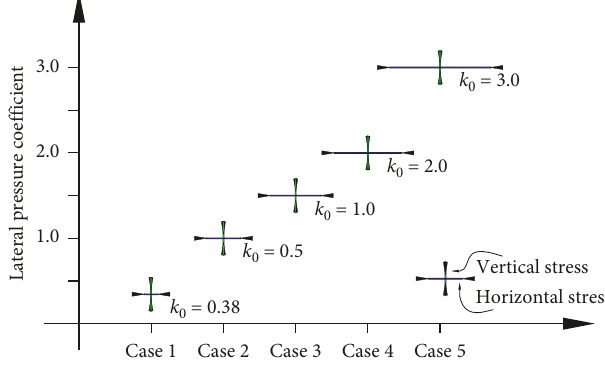
Figure 5: Lateral stress coefficient for five